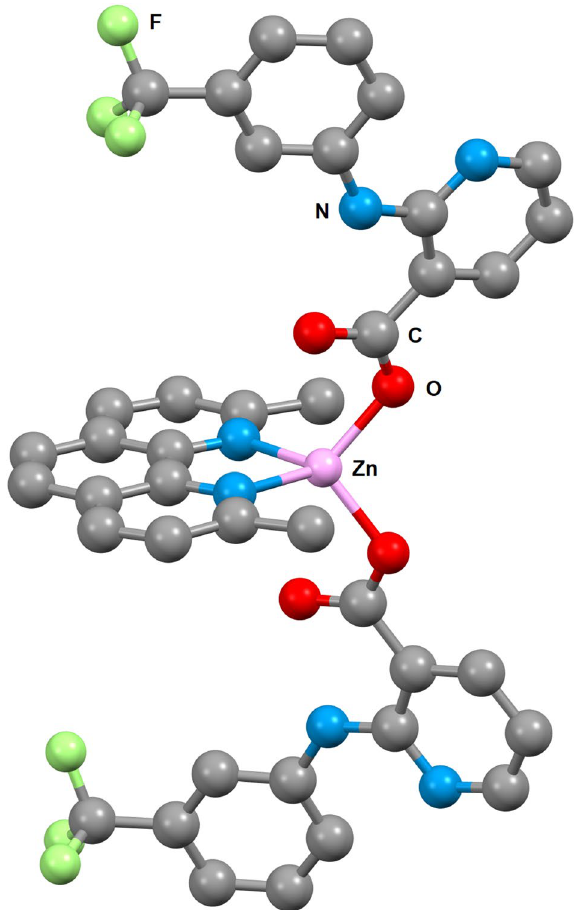
Figure 2. View of the molecular structure of studied complex [Zn( neo )( nif ) 2 ]. Hydrogen atoms were omitted for the sake of clarity (https:// www. ccdc. cam. ac. uk/ solut ions/ csd- core/ compo nents/ mercu ry/).